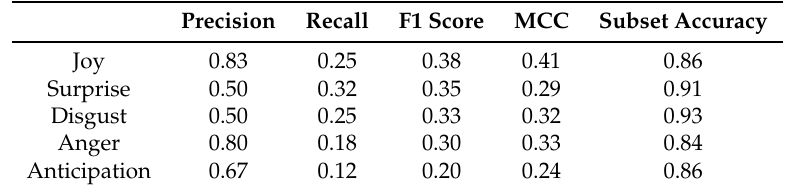
Table 10. Accuracy of fine-tuned setting in TF-IDF representation and added features, Multi-nomial Naive Bayes. Precision Recall